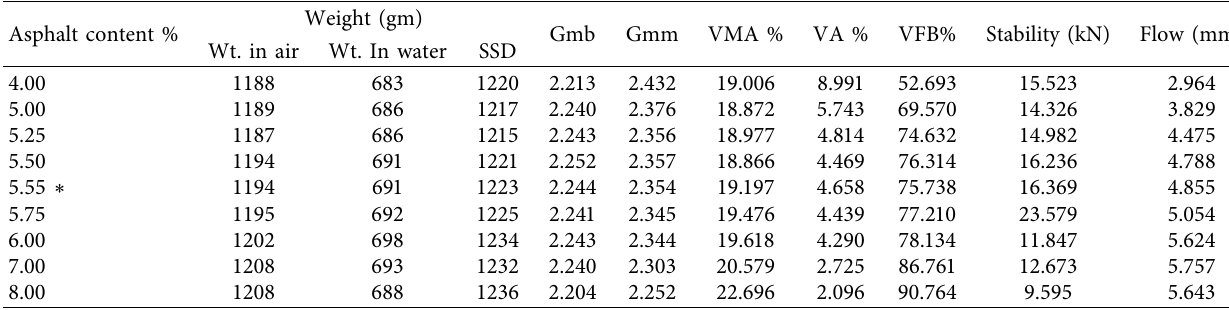
Table 11: Volumetric parameters of the AC mix with 7.5% CSD filler.